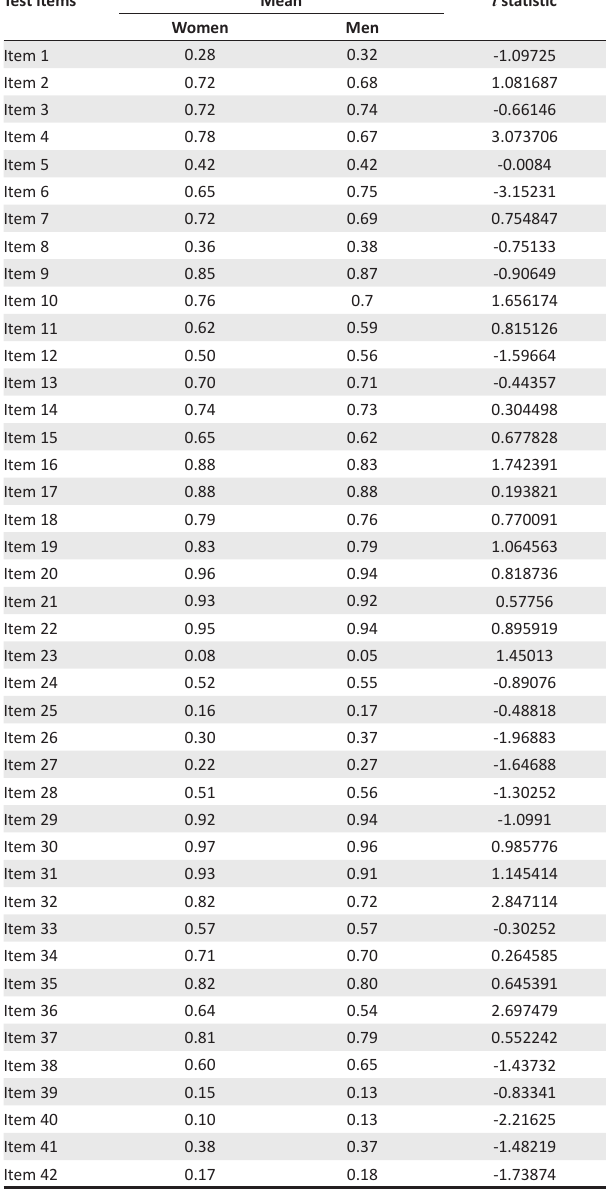
TABLE 2: Female and male means for English Comprehension Test 1.3.